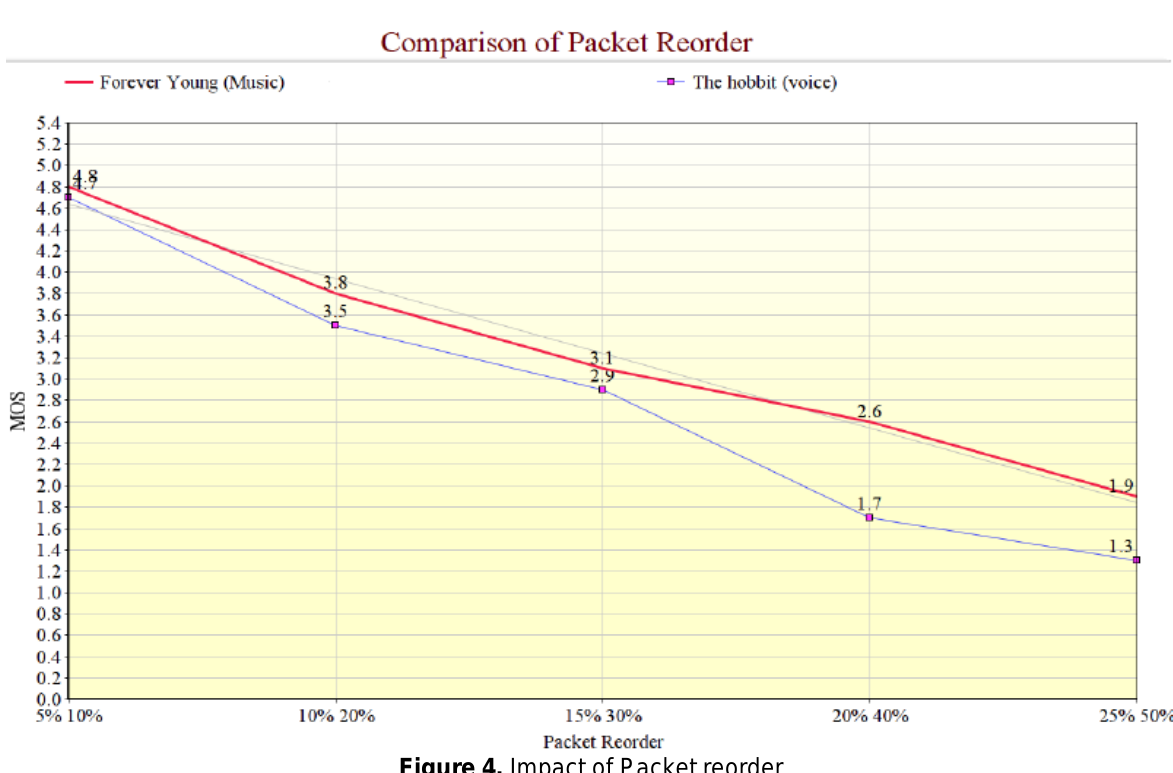
Figure 3. Impact of Packet loss